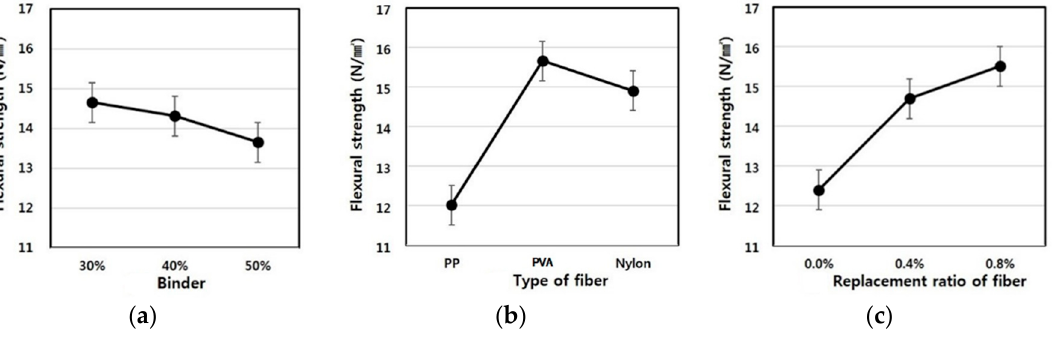
Figure 12. Assumed flexural strength of the extrusion panel by variance analysis: ( a ) replacement ratio of binder; ( b ) type of fiber; ( c ) replacement ratio of fiber.